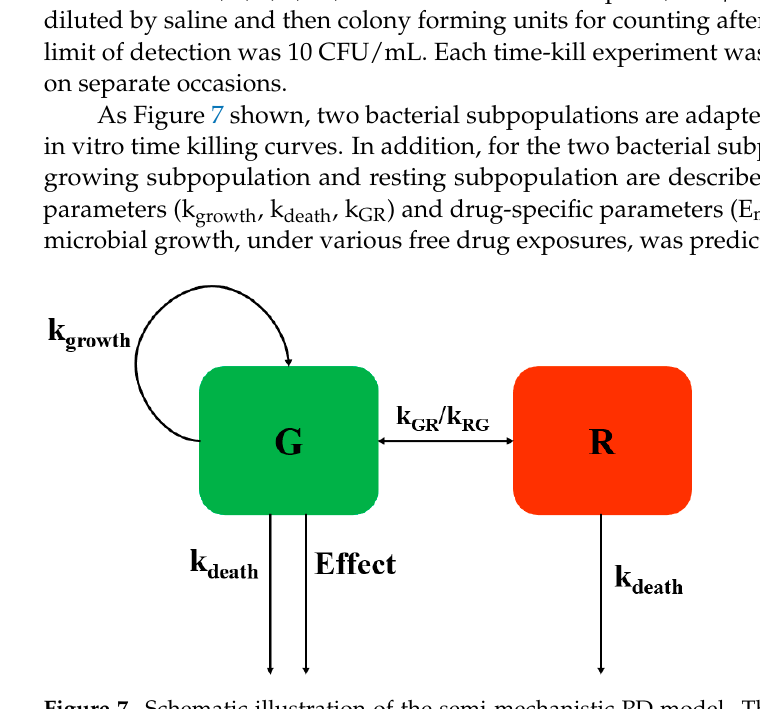
Figure 7. Schematic illustration of the semi-mechanistic PD model. The PD model includes one proliferating subpopulation (G) and one resting subpopulation (R). The bacterial system is described with first-order rate constants for multiplication of the bacteria in the growing subpopulation (k growth ), for the degradation of bacteria in both subpopulations (k death ), and for the transfer between the compartments (k GR and k RG ). The antibiotic concentration in the BioPhase compartment is assumed to stimulate the killing rate of bacteria in the susceptible stage according to an E max model (Effect).